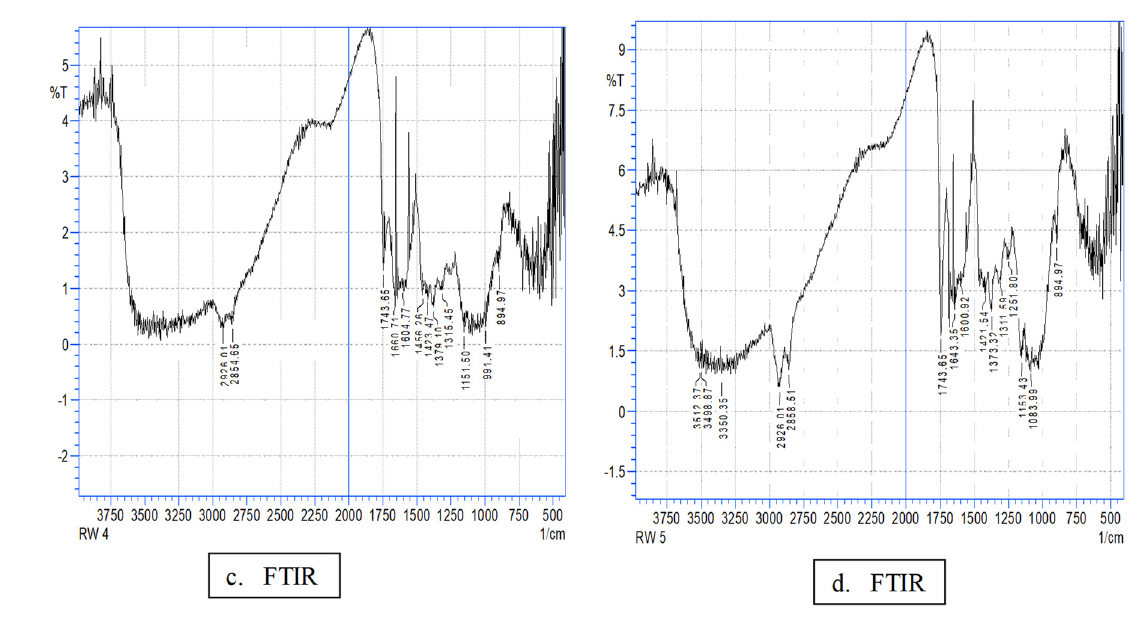
Figure 2. FT-IR spectrum of chitosan films with incorporated GEO at different concentrations. ( a ) Chitosan; ( b ) Chitosan + 0.1% GEO; ( c ) Chitosan + 0.2% GEO; ( d ) Chitosan + 0.3% GEO.